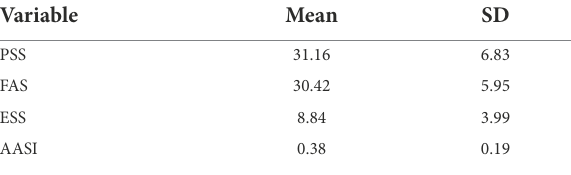
TABLE 2 PSS, FAS, ESS, and AASI